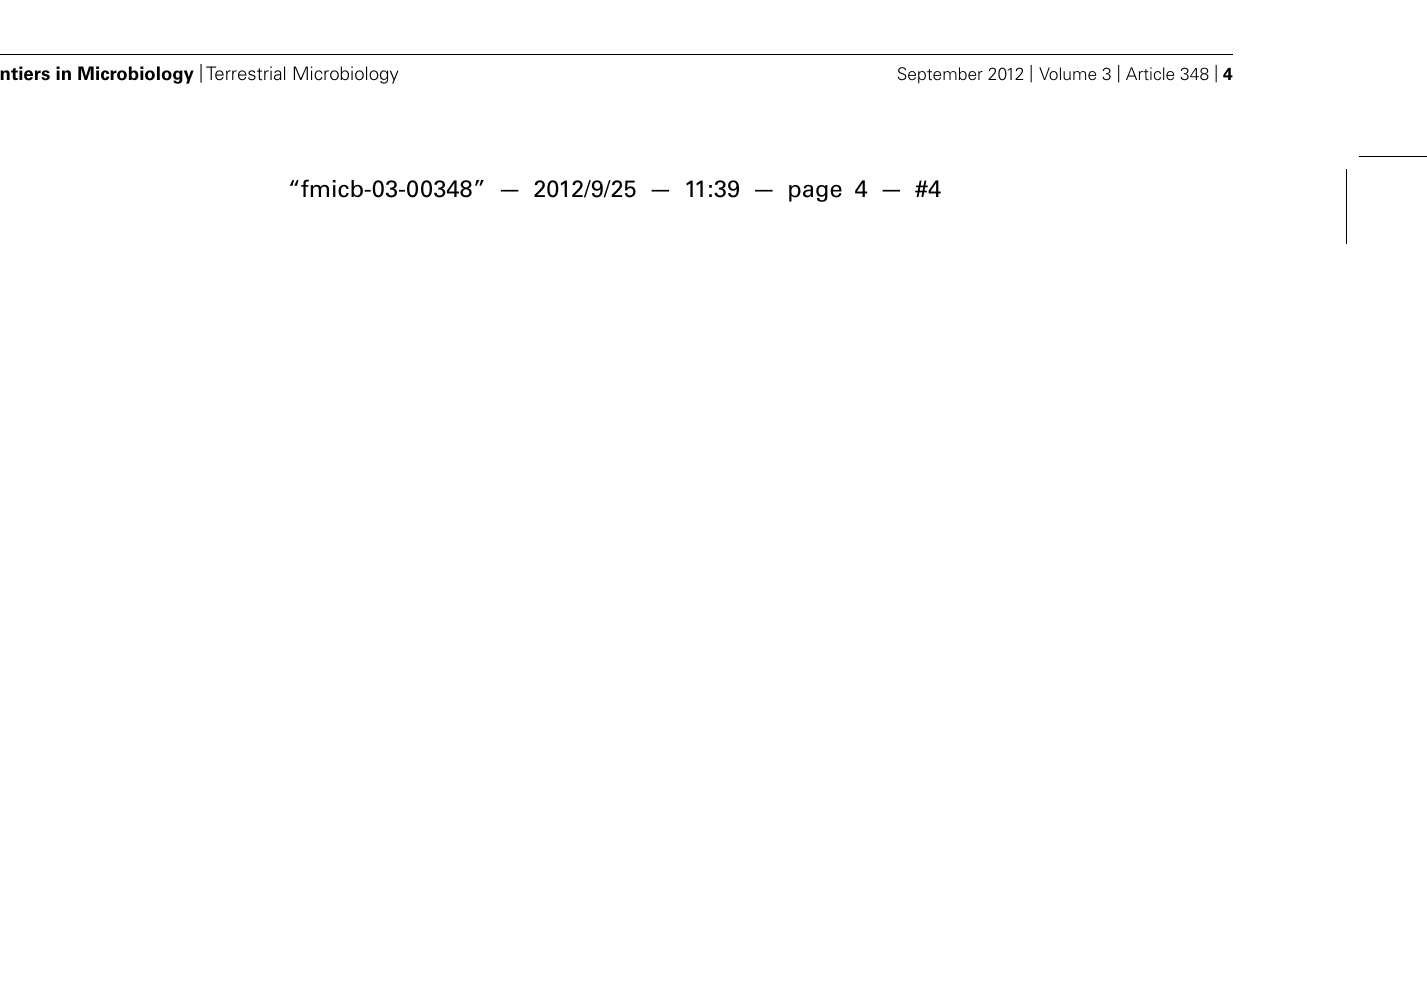
Frontiers in Microbiology |Terrestrial